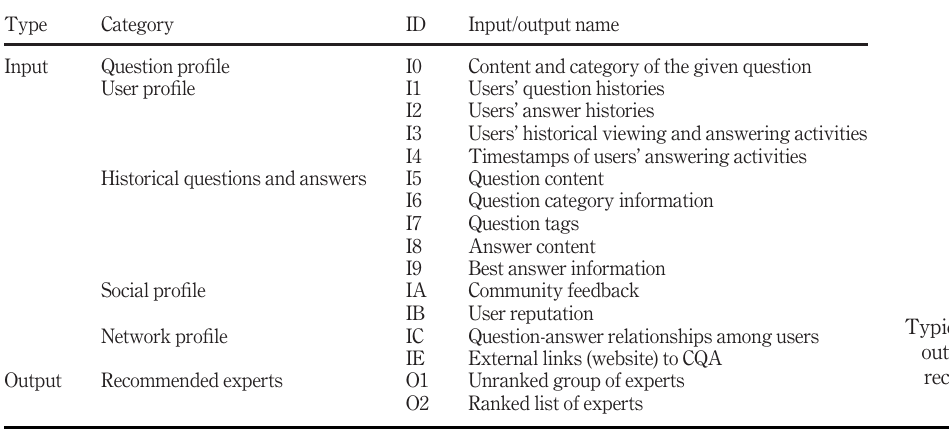
Table II. Typical inputs